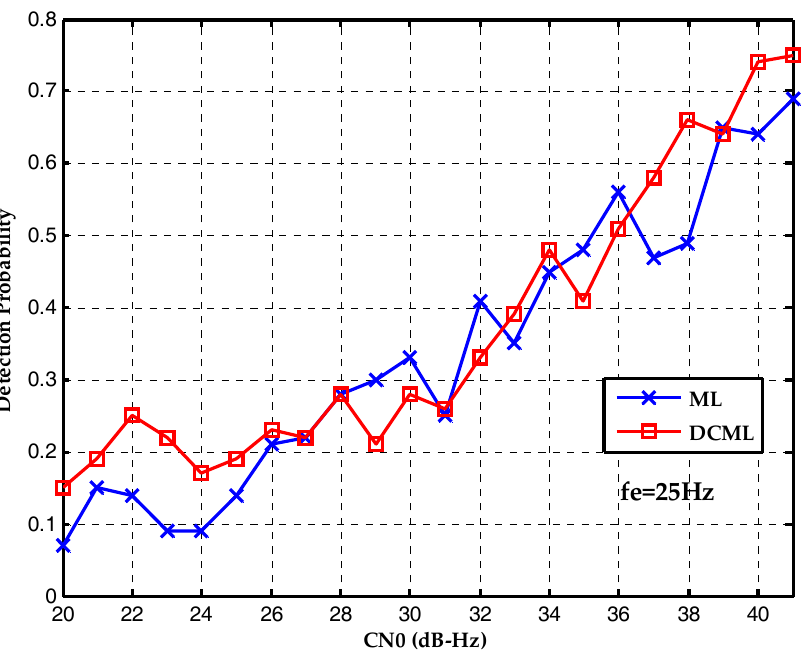
Figure 11. Detection probabilities of ML and DCML bit synchronization algorithms under the CN0s of 20~40 dB-Hz with a frequency deviation of 0 Hz.